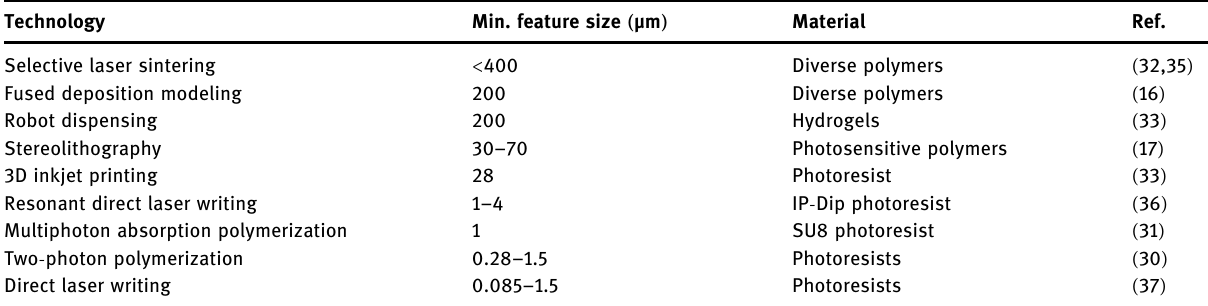
Table 1: Resolutions of di ff erent 3D printing technologies, reported in the literature, sorted from larger to smaller minimum feature sizes. From ref. ( 14 ) , originally published under a CC - BY license Technology